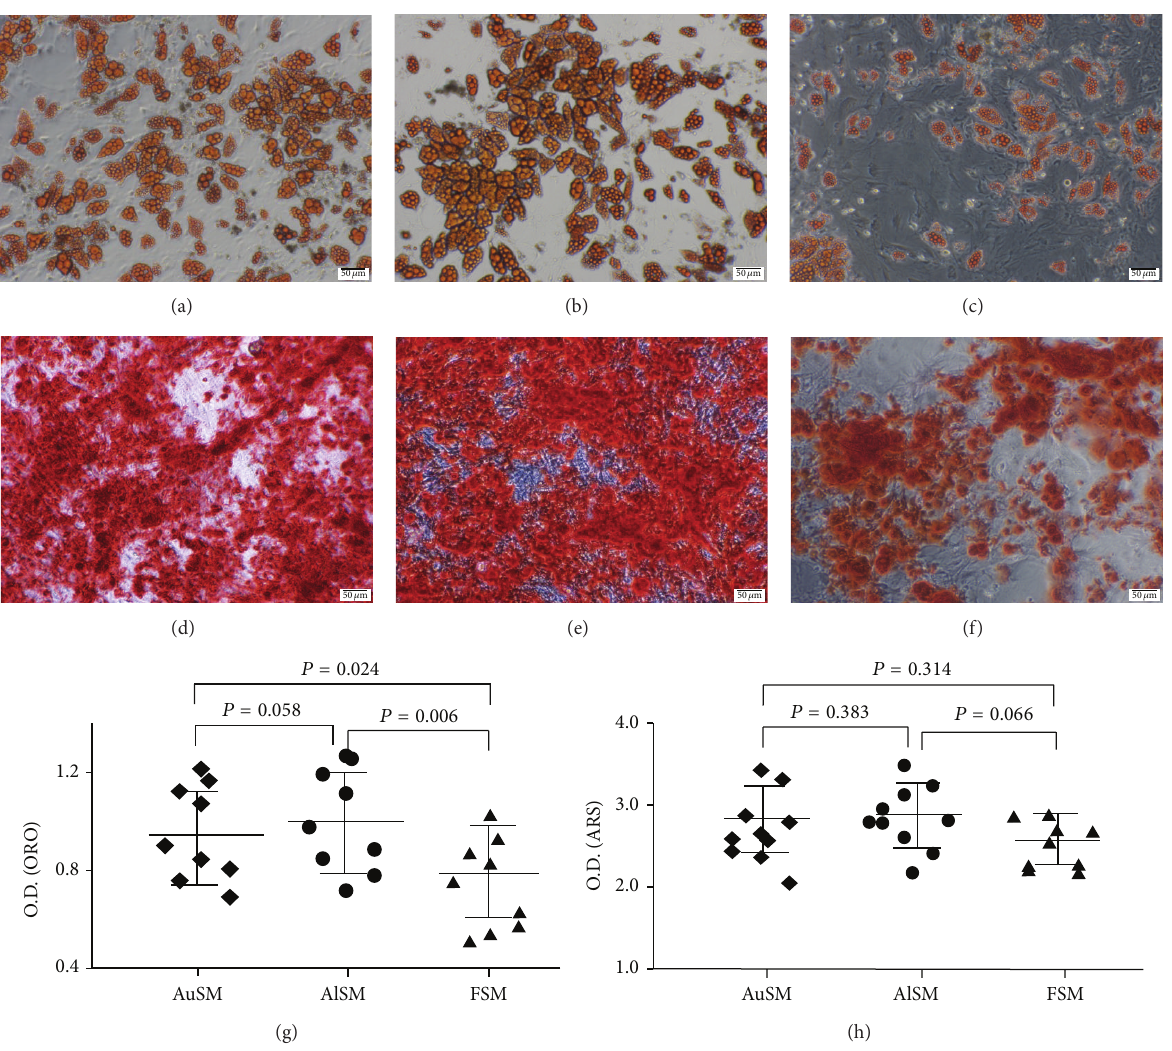
Figure 6: Differentiation potentials of BMSCs cultured in AuSM, AlSM, and FSM. (a–c) ORO staining of BMSCs cultured in (a) AuSM, (b) AlSM, and (c) FSM differentiated into adipocytes. (d–f) ARS staining of BMSCs cultured in (d) AuSM, (e) AlSM, and (f) FSM differentiated into osteocytes. (g) Quantification of oil droplets at 520 nm after ORO staining. (h) Quantification of mineralization at 405nm after ARS staining. Scale bars = 50 𝜇